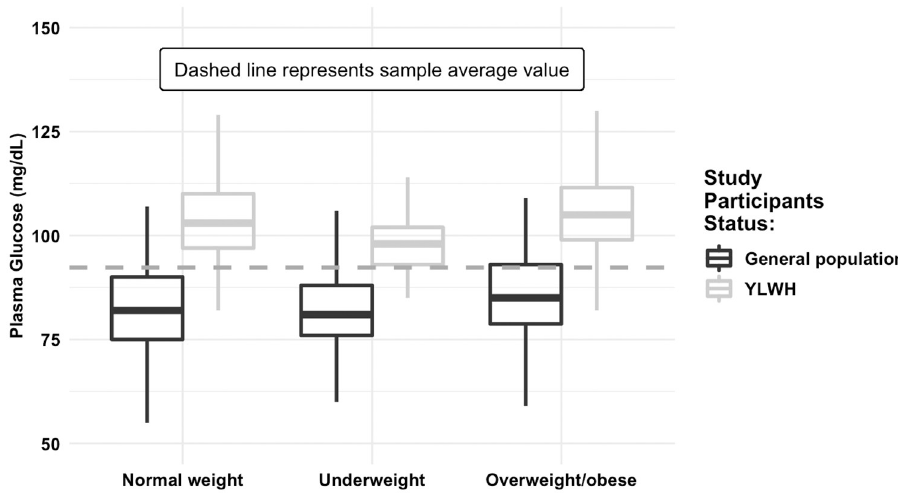
Fig 3. Plasma glucose levels among (fasting) study participants, stratified by sex. Source: 2016 UHS (n = 486) and 2019/2020 (n = 370) STEP surveys, Cambodia.